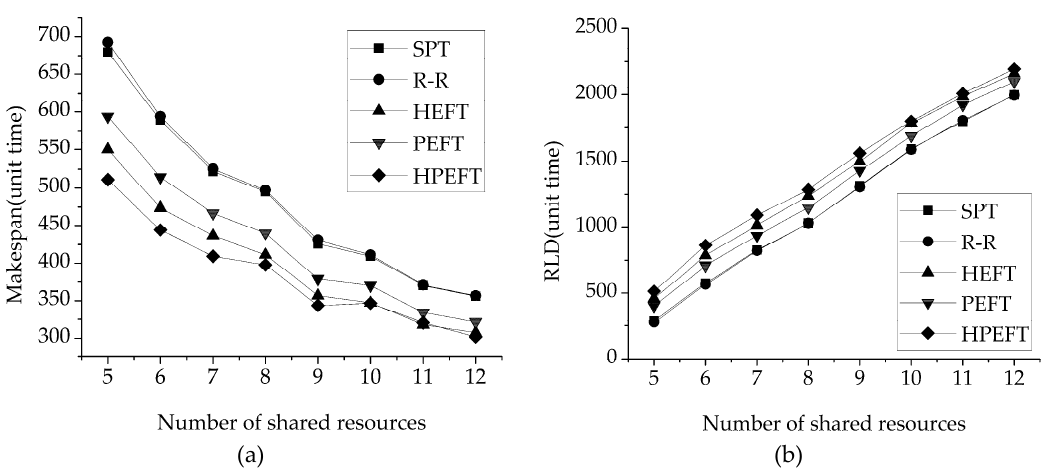
Figure 8. Variable number of shared resources: ( a ) makespan and ( b ) RLD.